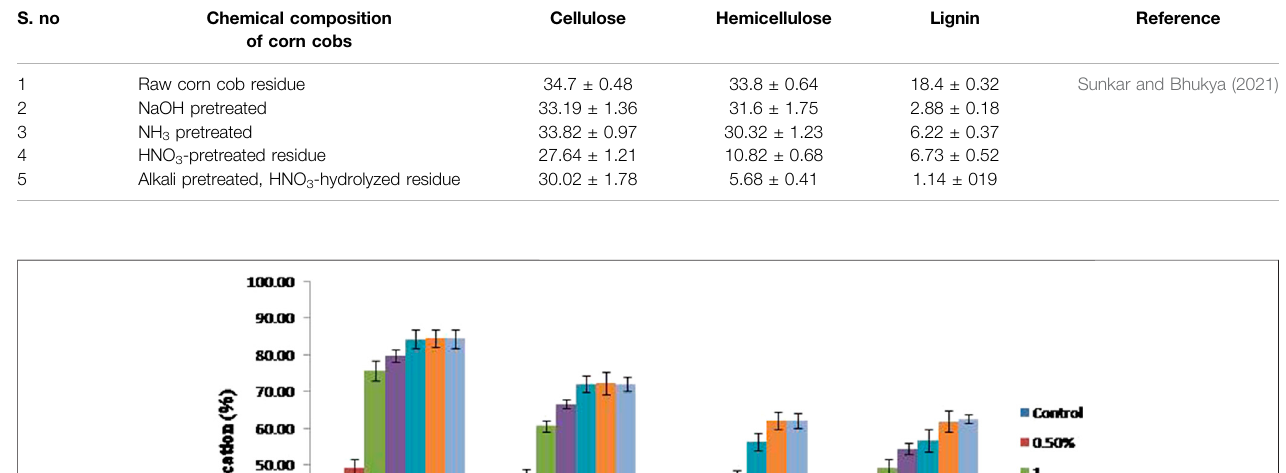
TABLE 1 | Analysis of chemical composition of raw and treated corn cobs residues.